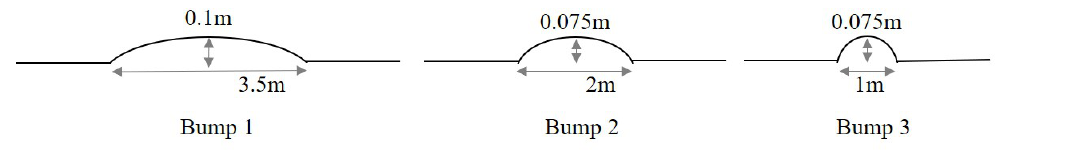
Figure 7. Shape of bumps.